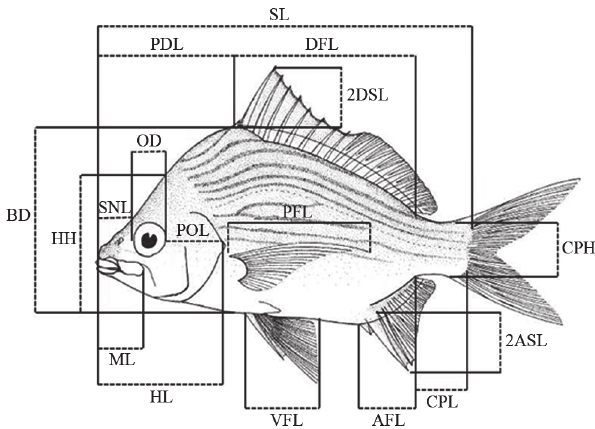
Fig. 1. Body measurements of external morphology used in morphometrics and principal component analysis: anal fin length (AFL); base of dorsal fin length (DFL); body depth (BD); caudal peduncle height (CPH); caudal peduncle length (CPL); head height (HH); head length (HL); maxillary length (ML); orbit diameter (OD); pectoral fin length (PFL); postorbital length (POL); predorsal length (PDL); standard length (SL); second anal spine length (2ASL); second dorsal spine length (2DSL); snout length (SNL); ventral fin length (VFL). Measurements based on González-Acosta (2005). Drawing modified from Bussing (1995). Not included in the illustration: inter-orbital length, third anal spine length, third dorsal spine length and distance between the tips of the second dorsal and second anal spines